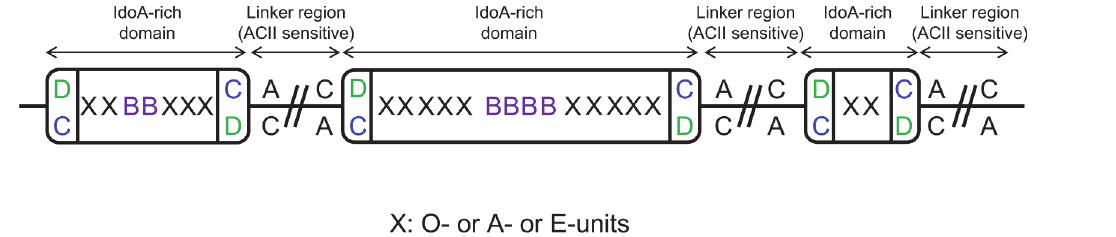
S1 Fig. Electropherogram of crude GAGs from various kinds of Elasmobranchii (shown in the upper portion of the figure ). Lanes from left to right: A, Scyliorhinus torazame ; B, Chimae- ra phantasma ; C, Deania calcea ; D, Dalatias licha ; E, Odontaspis ferox ; F, Chlamydoselachus anguineus ; G, Mitsukurina owatoni ; H, Mustelus griseus ; I, Dasyatis akajei . GAGs (approx. 5 μ g of each sample) were analyzed by electrophoresis on cellulose acetate membrane using 1 M pyridine-acetic acid buffer (pH3.5) at 0.5 mA/cm for 20 min. GAGs were stained by